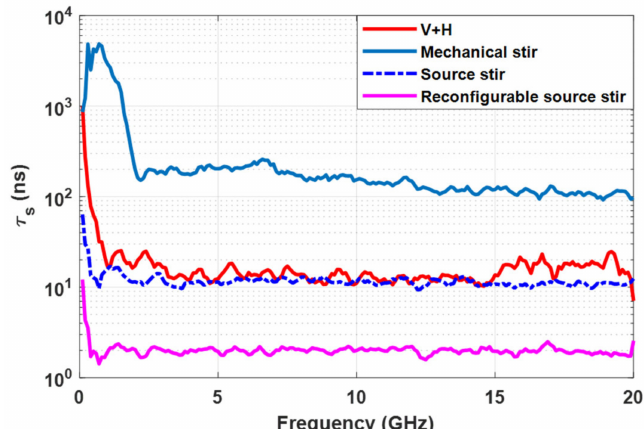
Figure 5. Measured scattering damping time τ s .